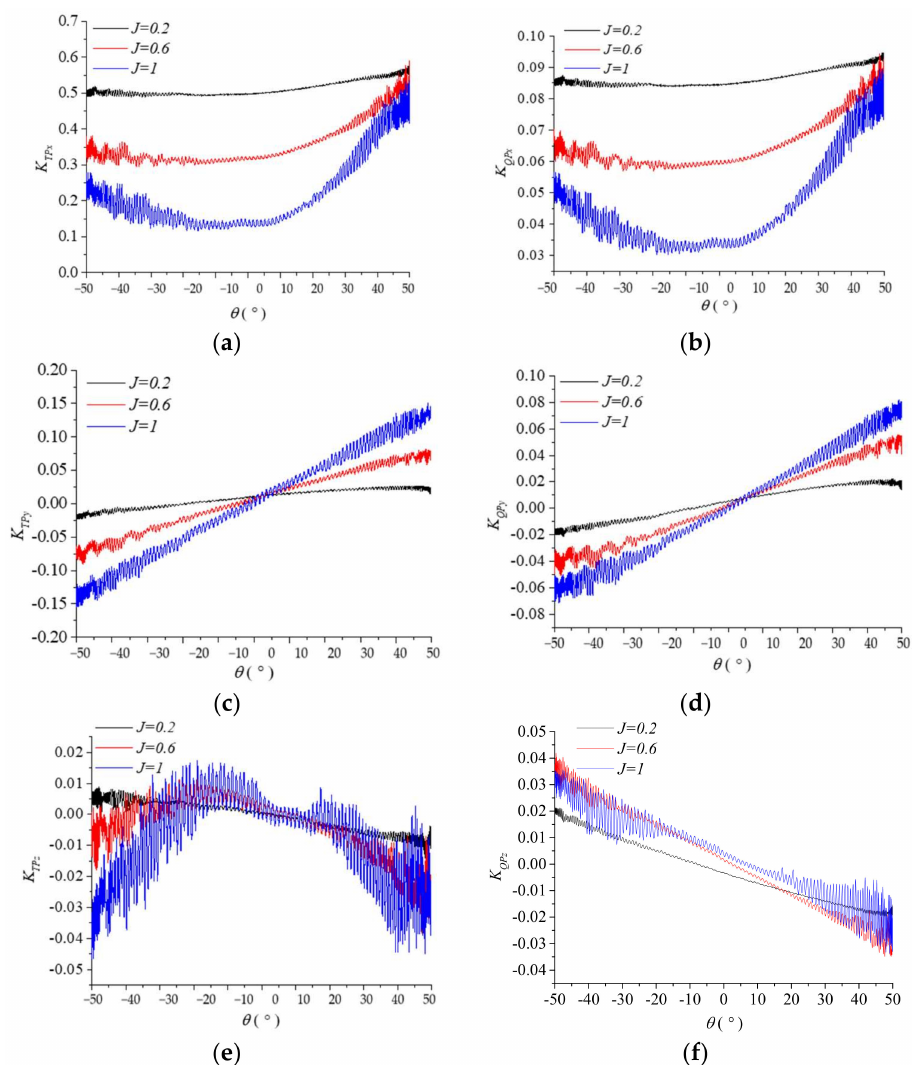
Figure 12. Comparison of propeller loads in each direction at different advanced coefficients: ( a ) K TPx ; ( b ) K QPx ; ( c ) K TPy ; ( d ) K QPy ; ( e ) K TPz ; ( f ) K QPz